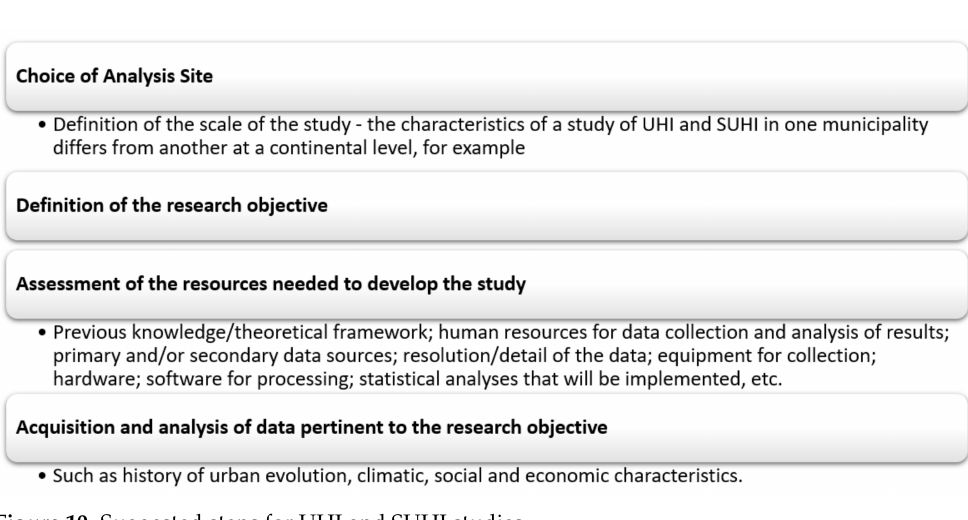
Figure 10. Suggested steps for UHI and SUHI